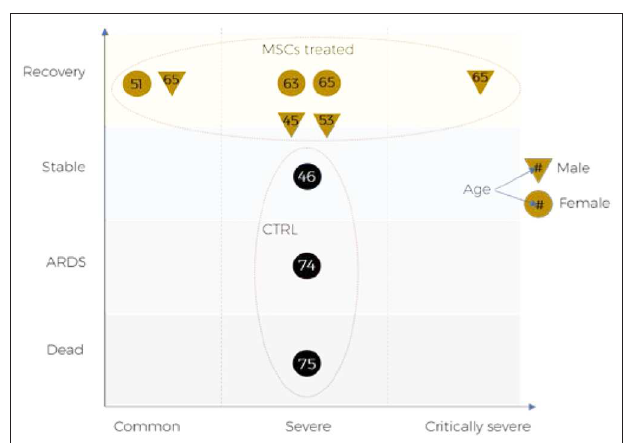
FIGURE 2 | Outcomes of MSCs treatment for COVID-19 patients reported in pilot clinical trial: